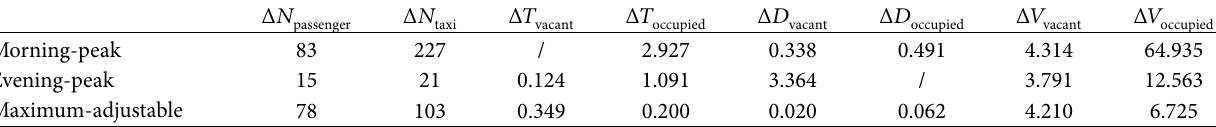
Figure 6: Variation of RETT caused by a single factor. Table 6: The adjustment of each factor for a 5% increment in